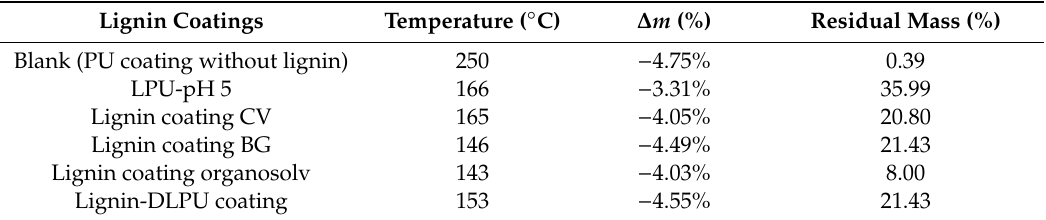
Table 6. Thermal stability for lignin and various LPU coatings with / without triphenylmethane (TPM) derivatives. Lignin Coatings